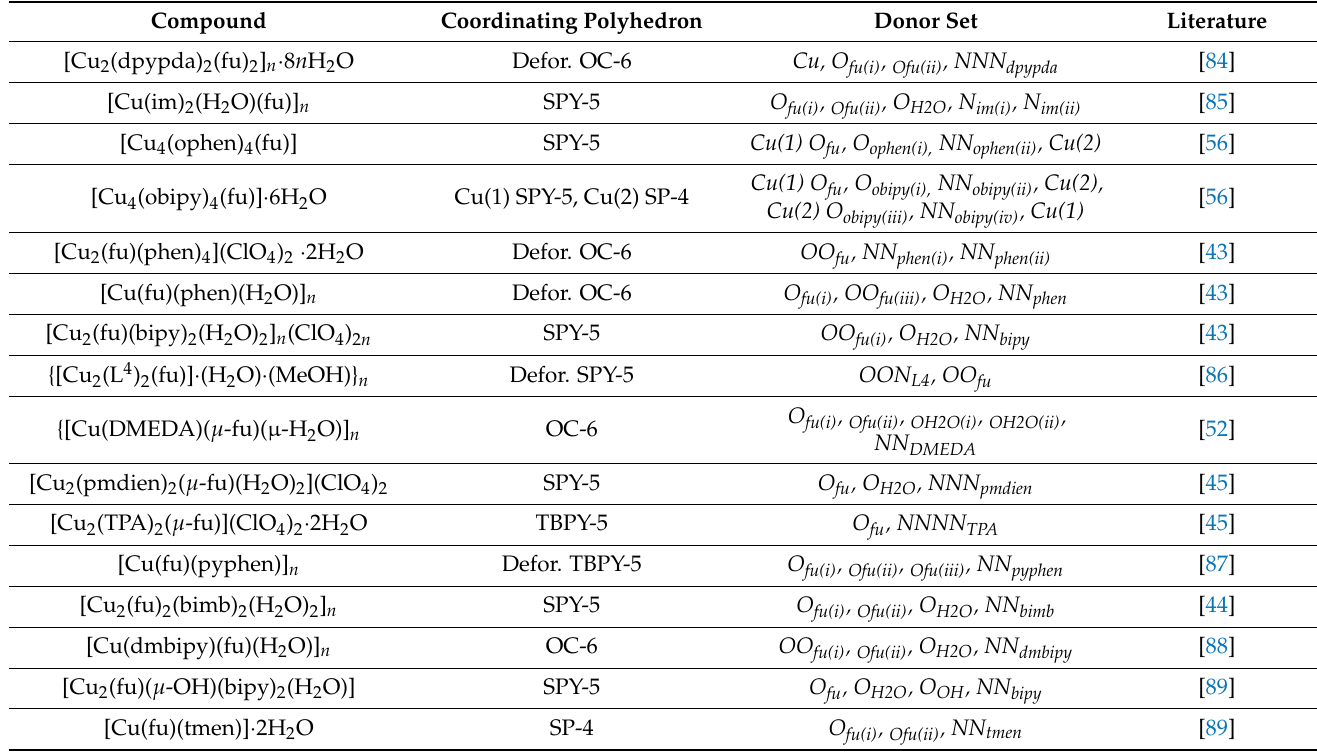
Table 4. List of structurally characterized coordination compounds of copper with fumaric acid and N donor